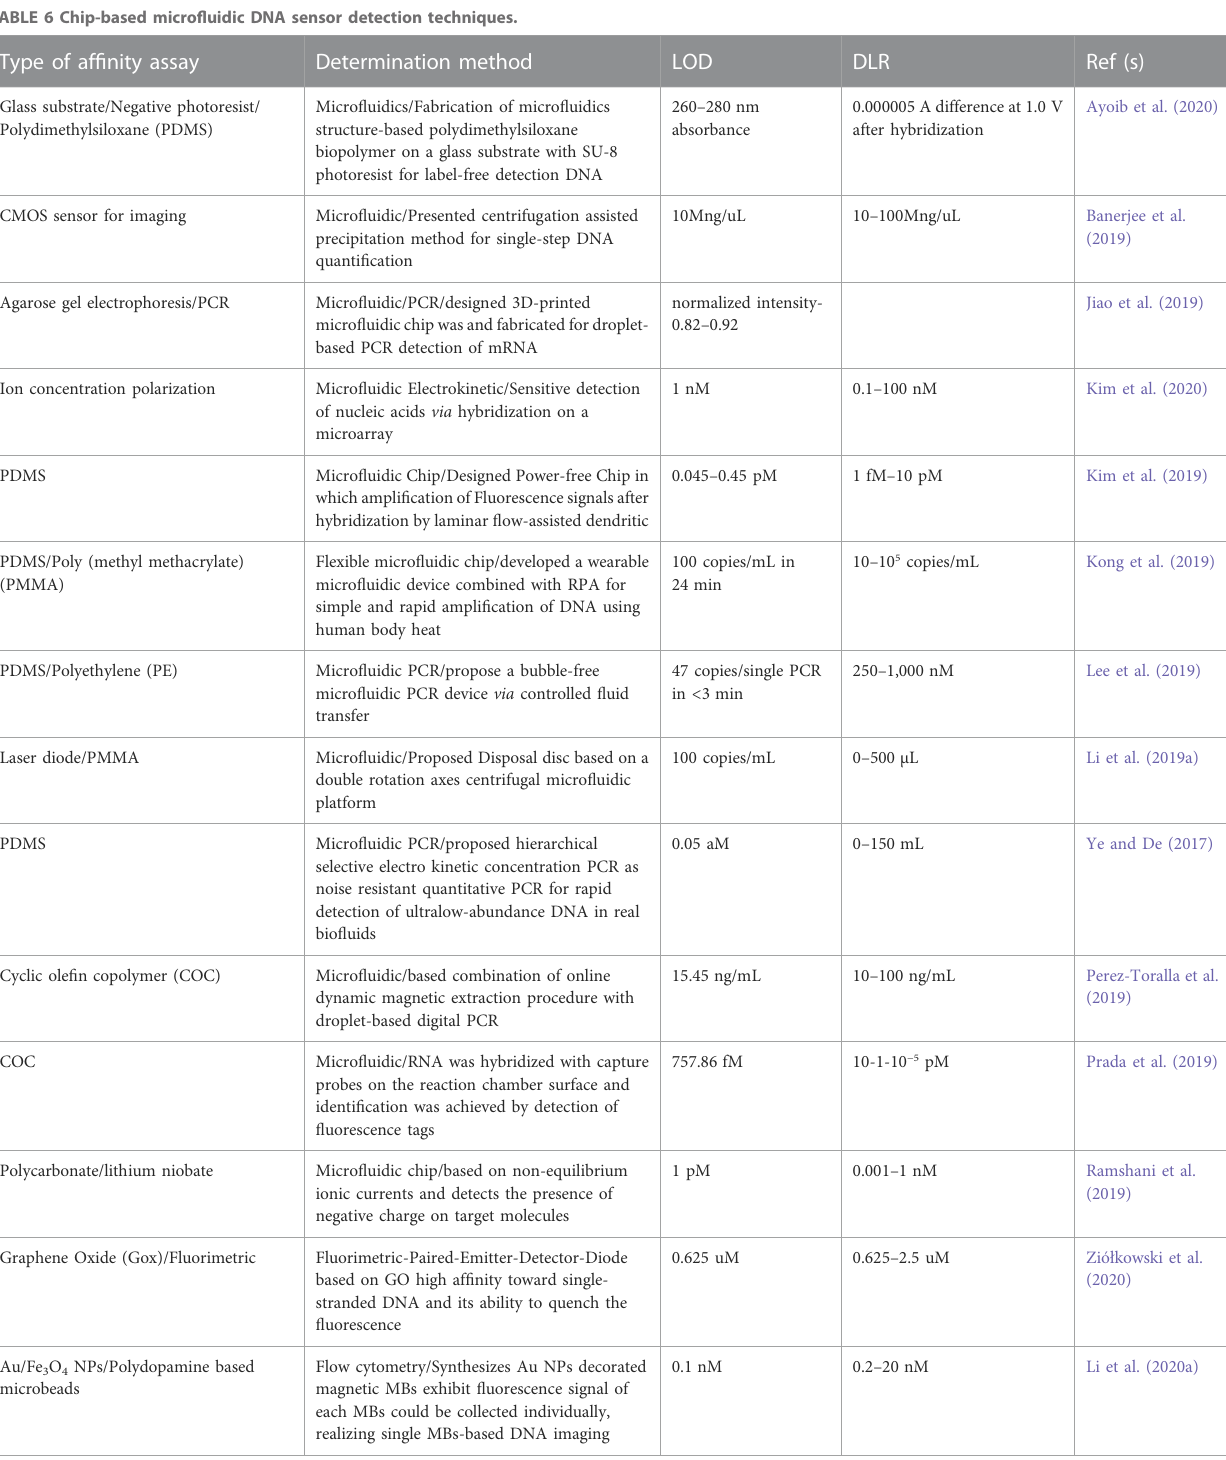
TABLE 6 Chip-based micro fl uidic DNA sensor detection techniques. Type of af fi nity